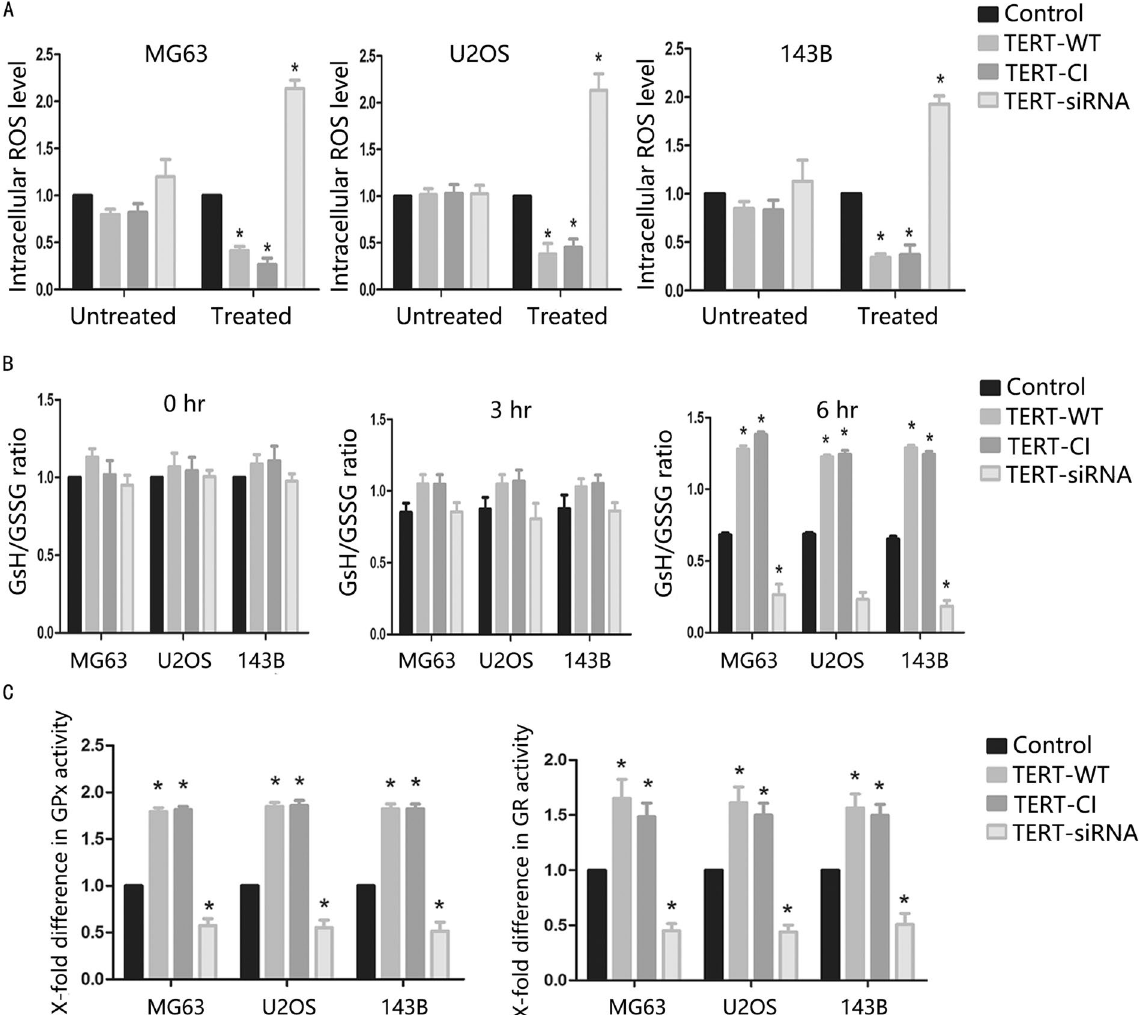
performed to evaluate the difference * P <